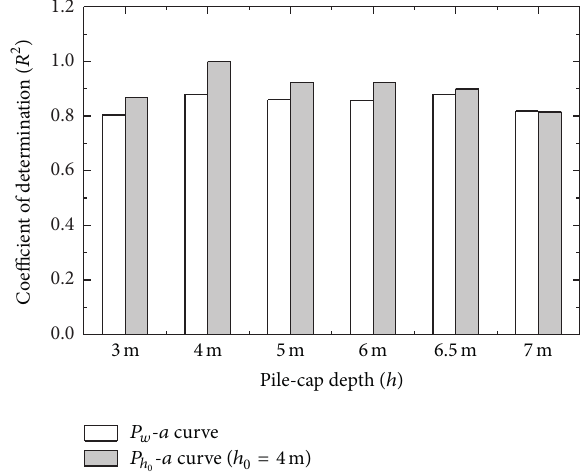
Figure 14: Correlation analysis of different benchmark curves (5,000